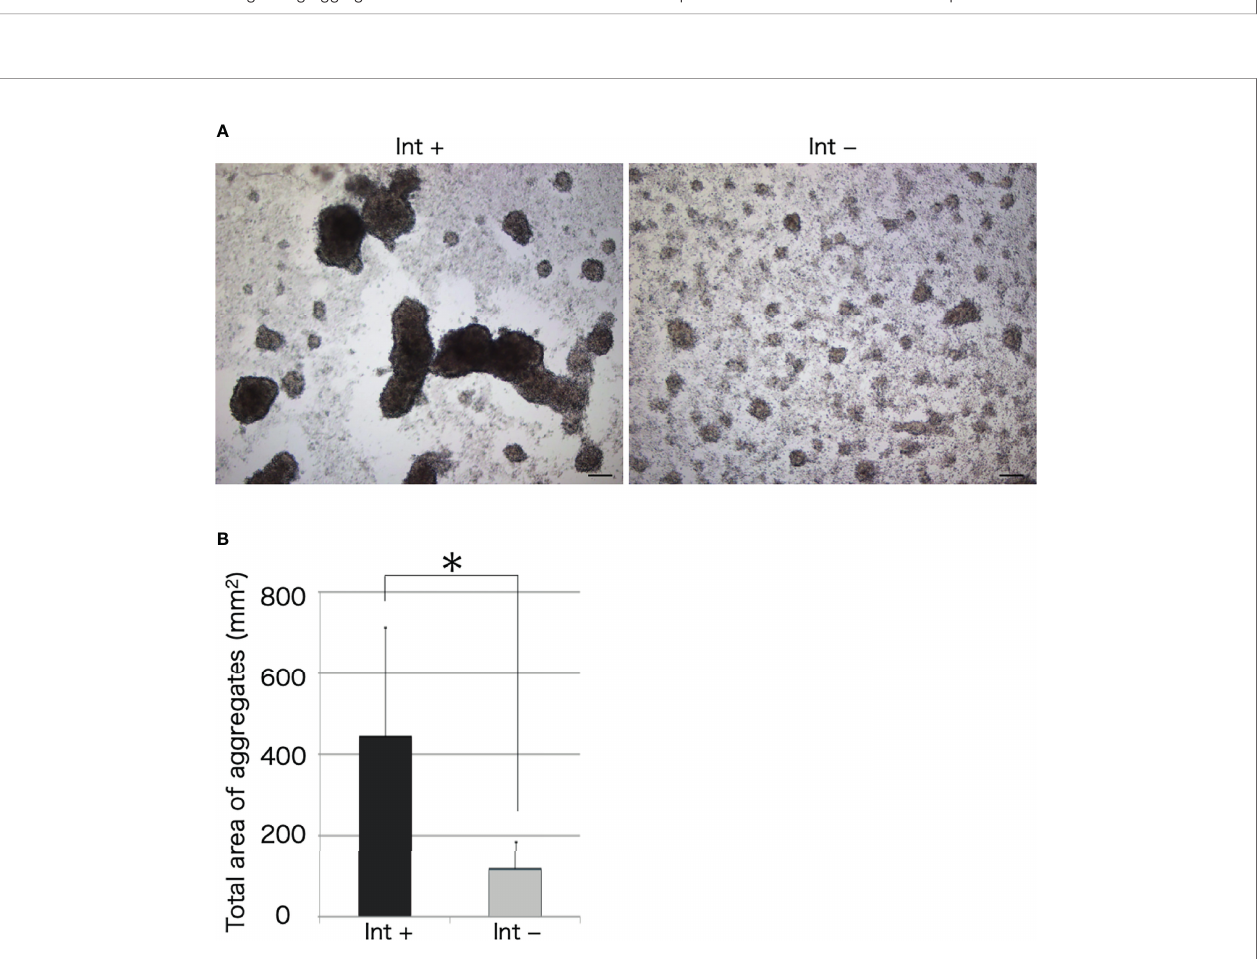
FIGURE 3 | Microscopic observation of cellular aggregates with (Int+) or without (Int-) an intestinal piece on a glass slide. (A) Aggregates formed in the presence and absence of the intestine at 30 min. Scale bars = 100 m m. (B) Comparison of the total area of cell aggregates. * P < 0.05 (mean ± SD, n = 5).